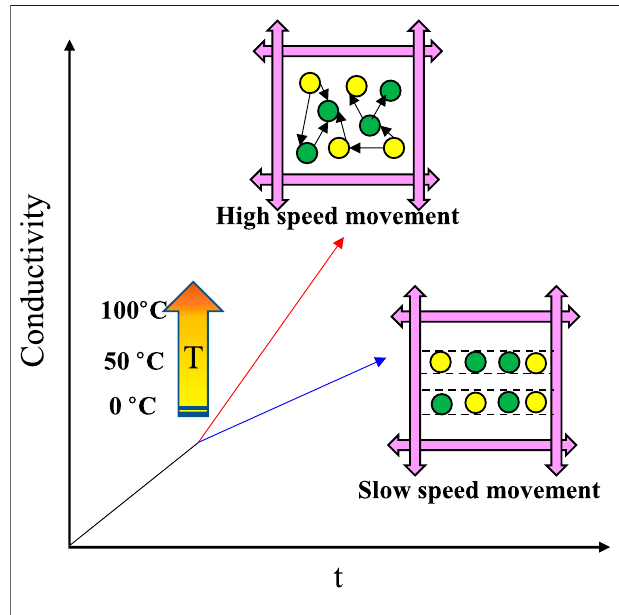
FIGURE 10 | Schematic diagram of disintegration in fl uenced by